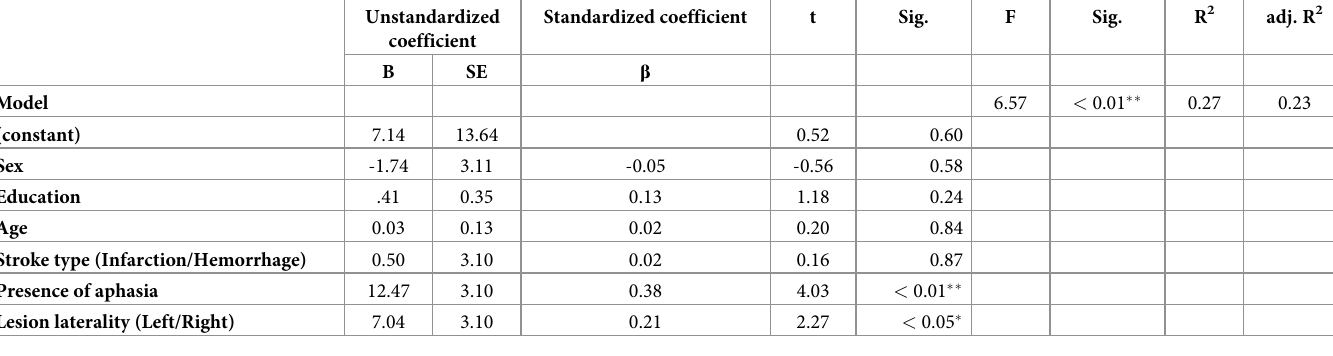
Table 6. Multiple regression analysis summary for factors predicting categorical naming test scores in stroke